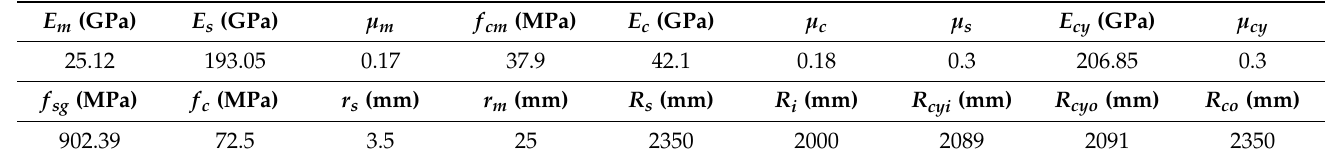
Table 1. Material and geometrical parameters of the